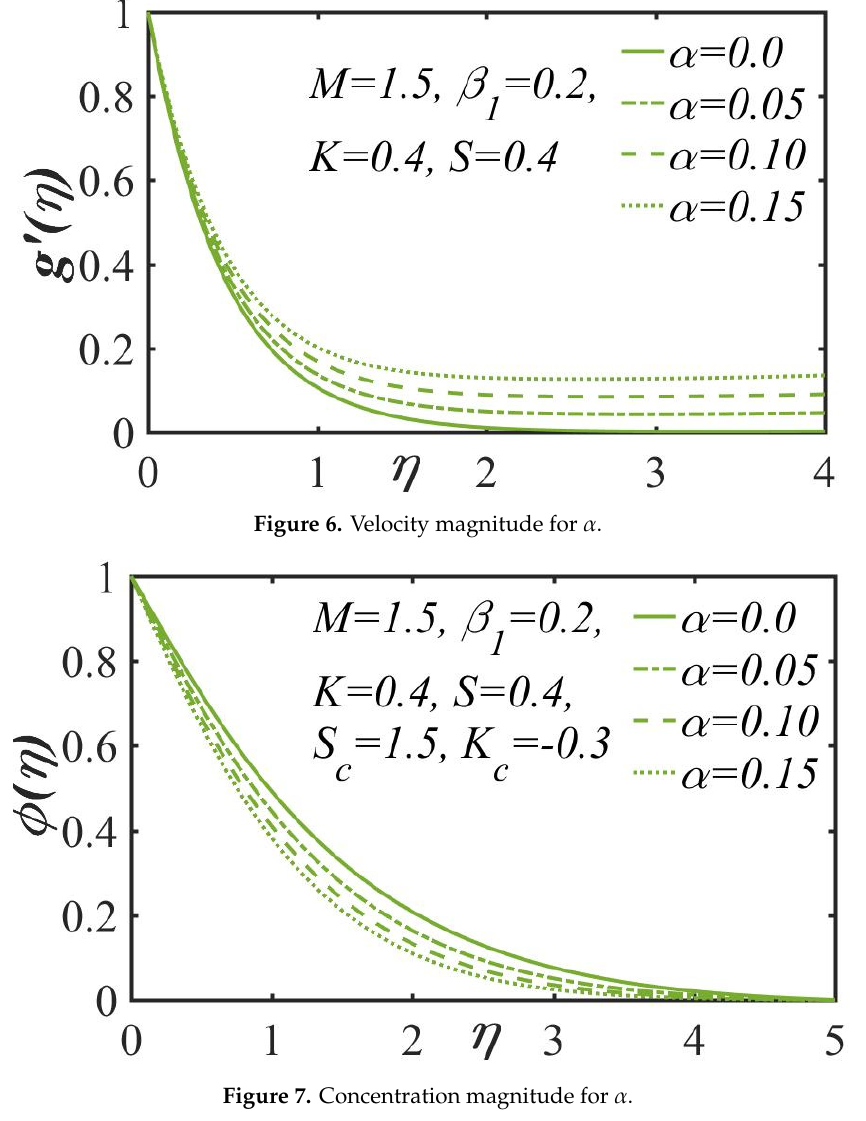
Figure 7. Concentration magnitude for (cid:2009) .